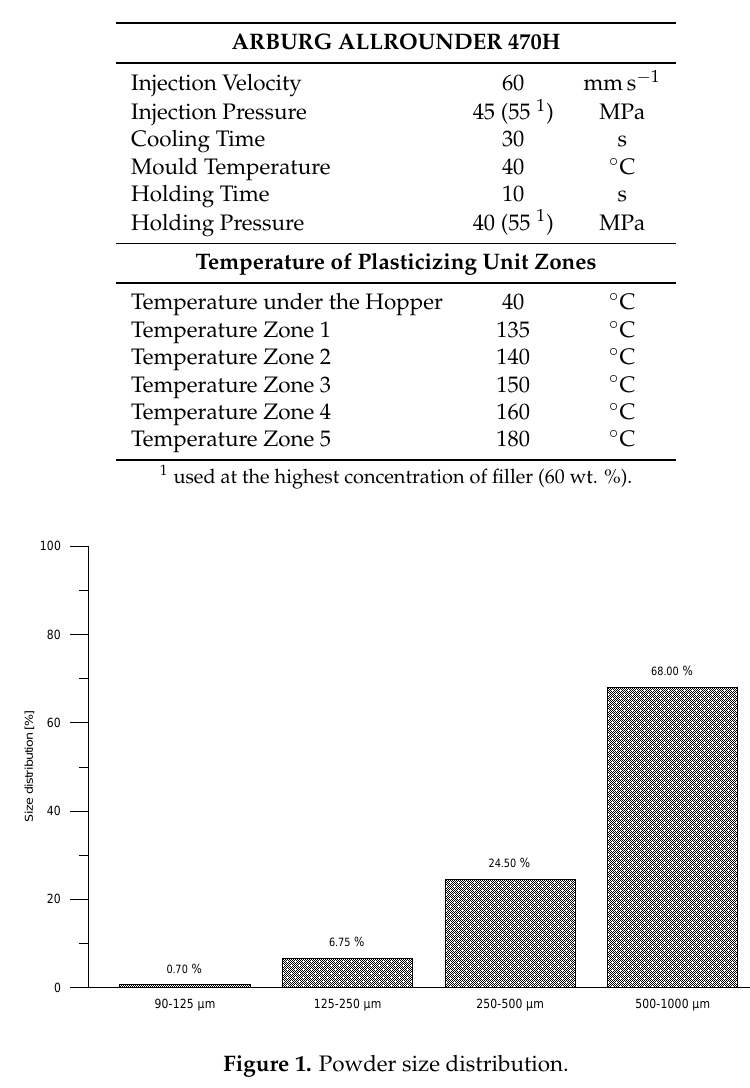
Table 1. Injection moulding processing parameters.